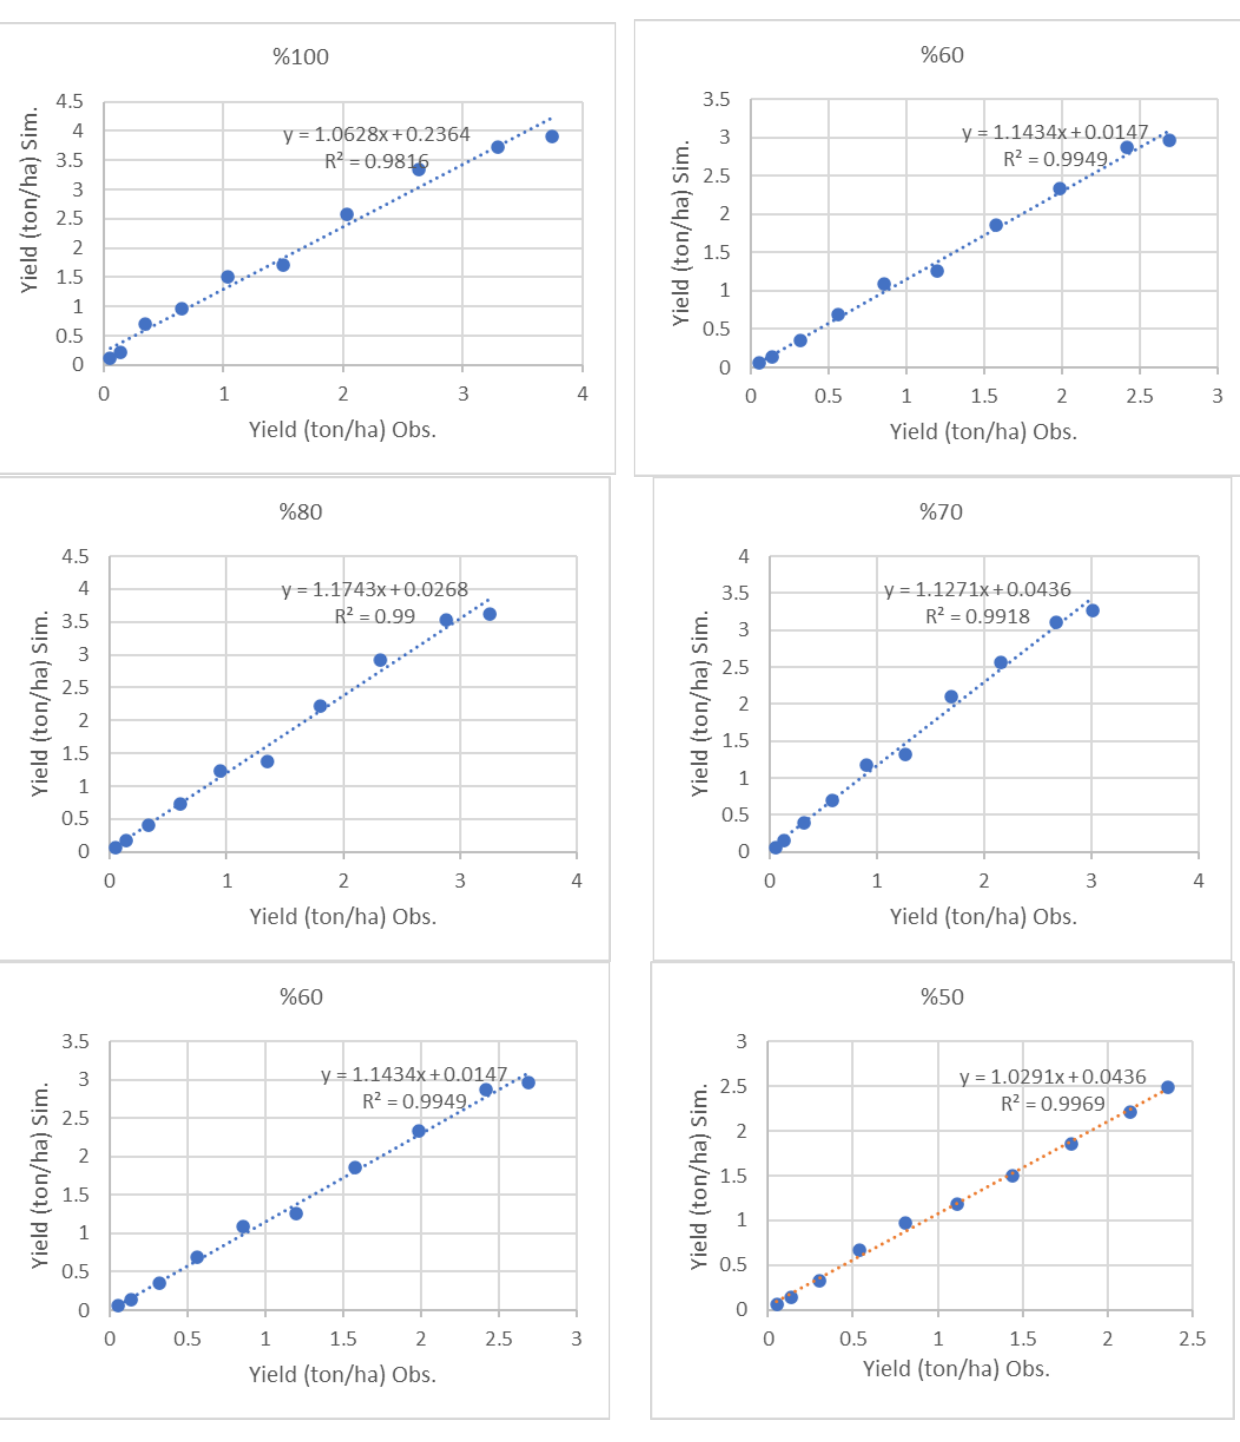
Figure 9. The results of model calibration for simulating the crop yield of the barley crop under different irrigation conditions.